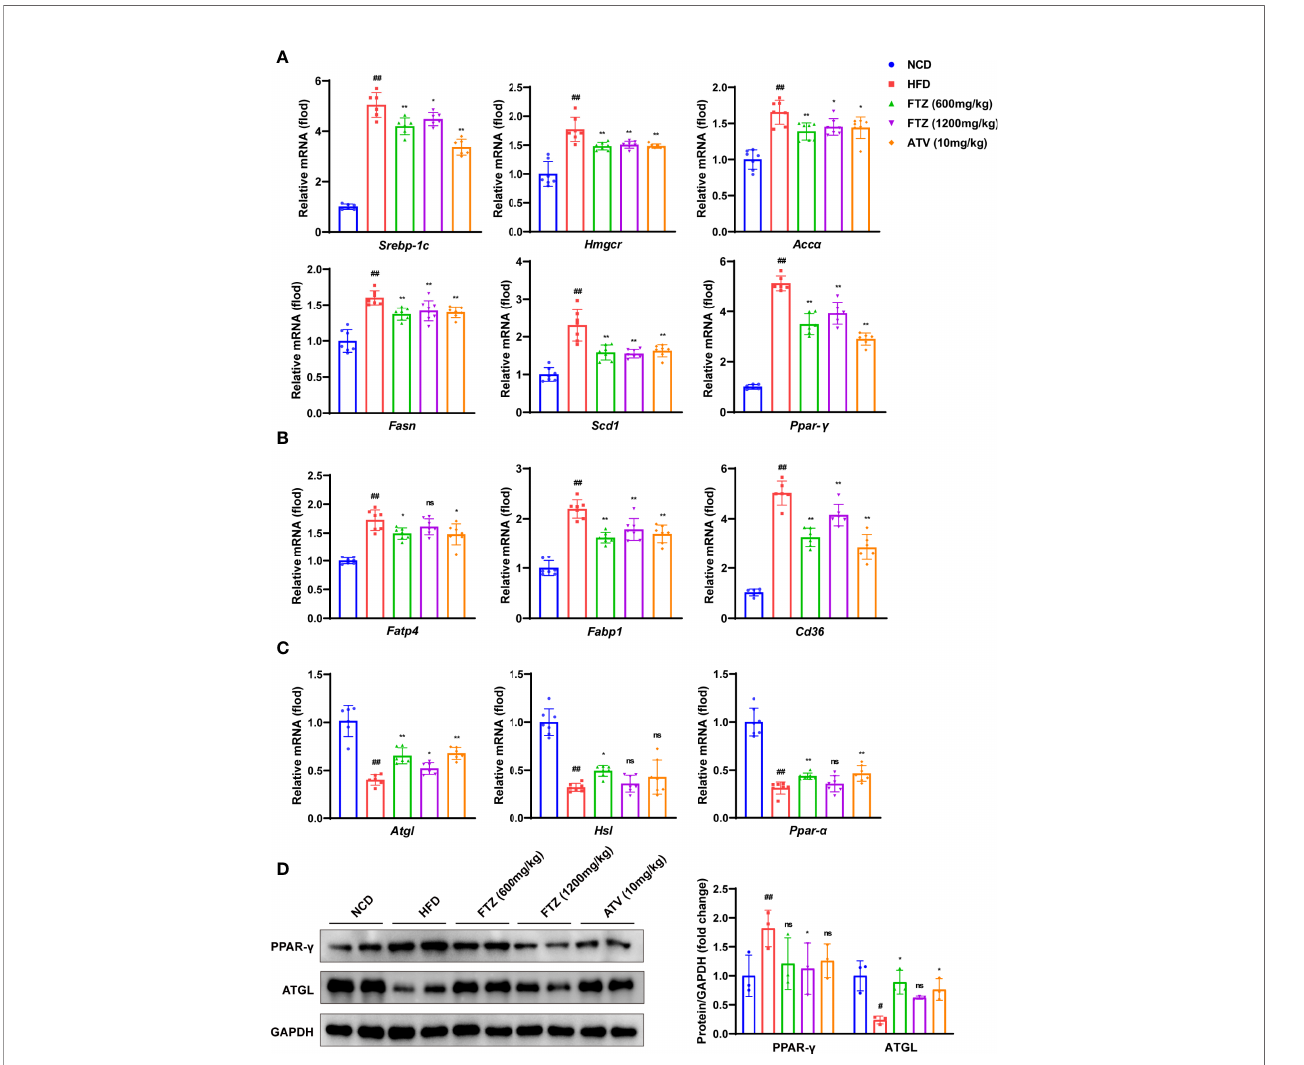
FIGURE 3 | Effects of FTZ on liver lipid metabolism in mice. (A – C) The mRNA expression levels of genes associated with fatty acid synthesis, transport, lipolysis, and b -oxidation (n=6-7). (D) The expression of PPAR- g , ATGL, and GAPDH was analyzed by Western blotting. GAPDH served as a loading control (n=3). Data are represented as means ± SEM. # indicates a signi fi cant difference between the NCD group and the HFD group (t-test); * indicates a signi fi cant difference between the FTZ (600 mg/kg)/FTZ (1,200 mg/kg)/ATV (10 mg/kg) group and the HFD group (one-way ANOVA). # P < 0.05, ## P < 0.01 versus NCD mice; * P < 0.05, ** P < 0.01 versus mice fed by HFD. ns indicates no signi fi